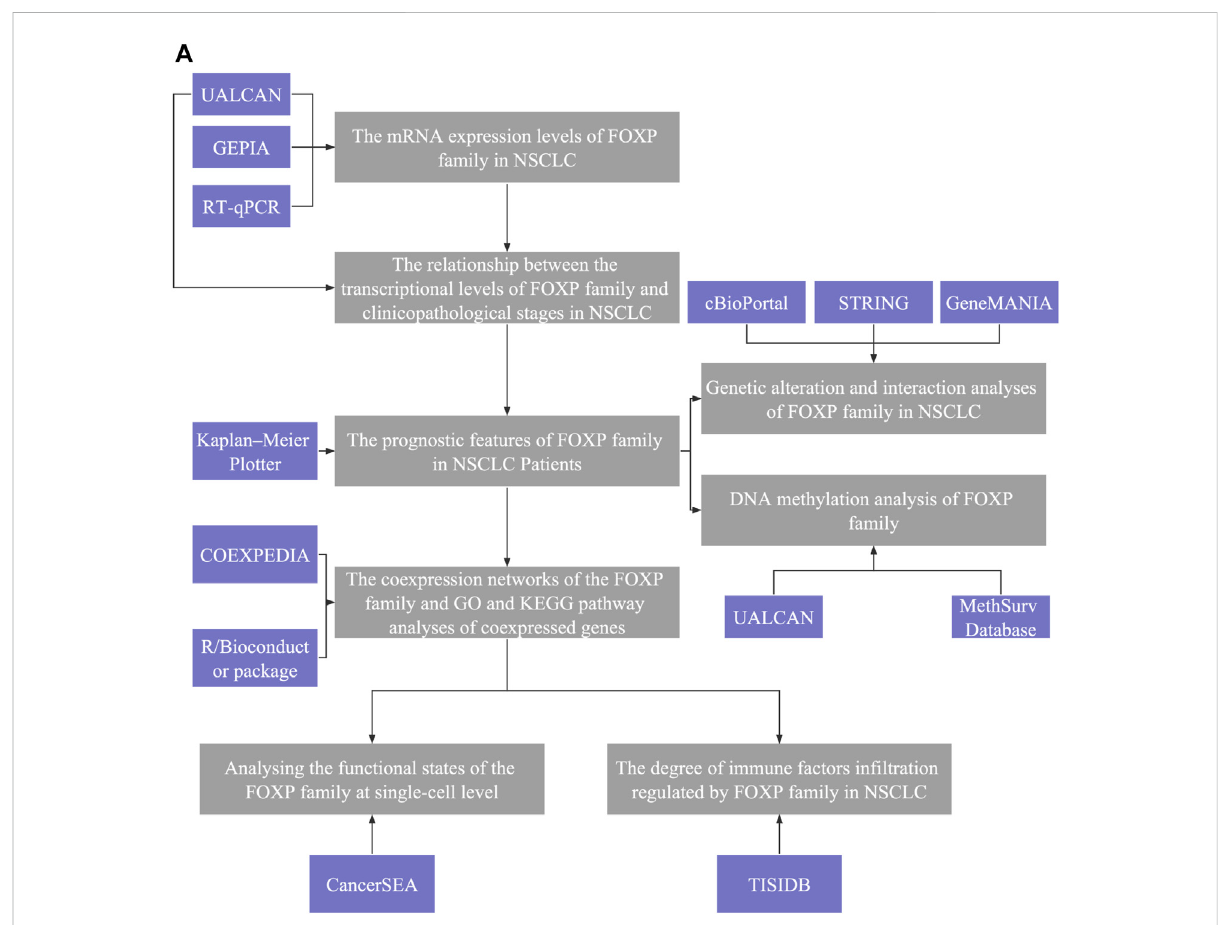
FIGURE 1 Analysisexplanationwithadetailed fl owdiagramofthisstudy. (A) Thestudycomprisedeightparts: Ⅰ ThemRNAexpressionlevelsofFOXPfamily inNSCLC; Ⅱ TherelationshipbetweenthetranscriptionallevelsofFOXPfamilyandclinicopathologicalstagesinNSCLC; Ⅲ Theprognosticfeaturesof FOXP family in NSCLC patients; Ⅳ The coexpression networks of the FOXP family and GO and KEGG pathway analyses of coexpressed genes; V Analysing the functional states of the FOXP family at single-cell level; VI The degree of immune factors in fi ltration regulated by FOXP family in NSCLC; VII Genetic alteration and interaction analyses of FOXP family in NSCLC; VIII DNA methylation analysis of FOXP